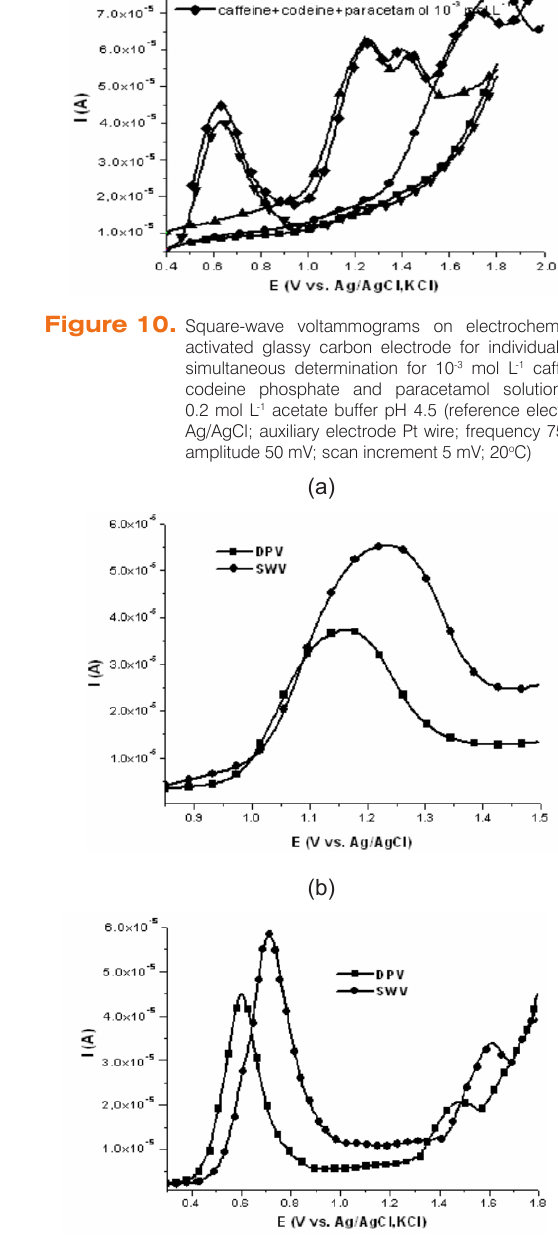
Figure 11. Square-wave (frequency 75 Hz; amplitude 50 mV; scan increment 5 mV) and differential pulse (scan rate 0.04 V s -1 ; amplitude 100 mV; modulation time 5 ms) voltammograms obtained on electrochemically activated glassy carbon electrode for: (a) Miofilin ® (aminophylline) and (b) Saridon